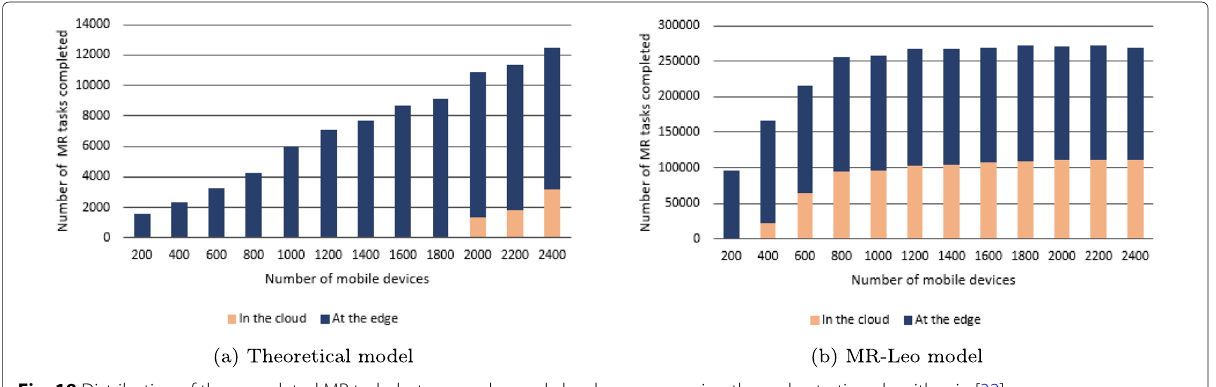
Fig. 18 Distribution of the completed MR tasks between edge and cloud resources using the orchestration algorithm in [32]